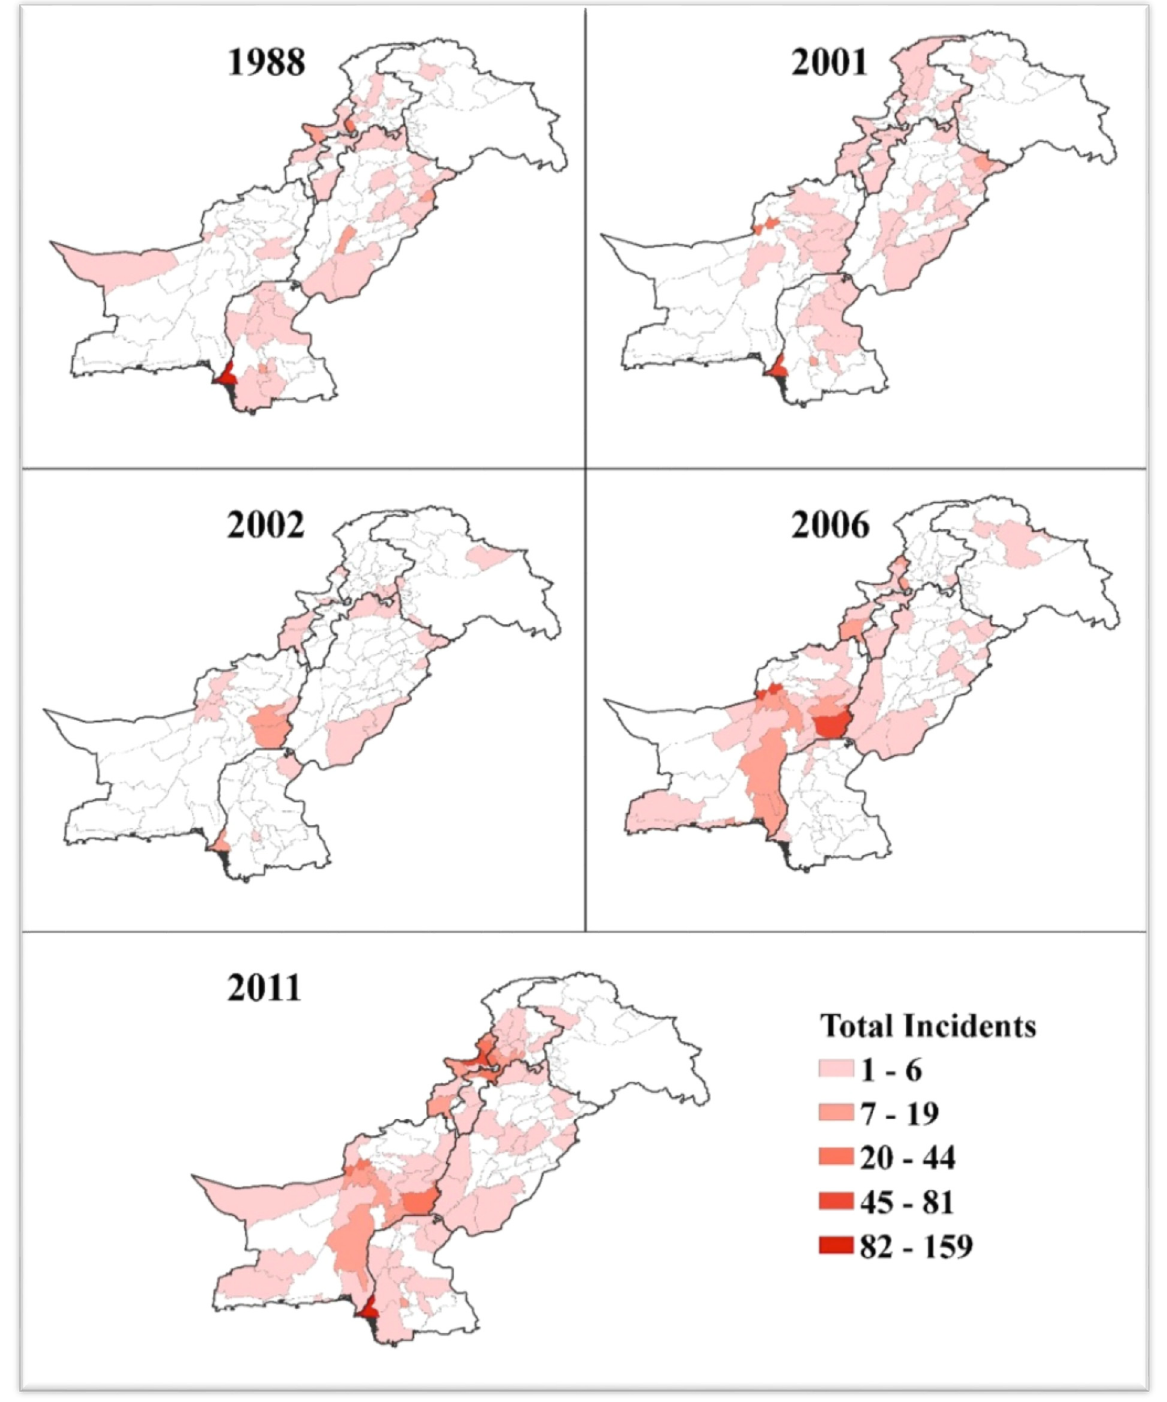
Figure 4. Terrorist Violence in Pakistan-Selected Years. Source: In-house manipulations of BFRS dataset by [29,61] Jesse